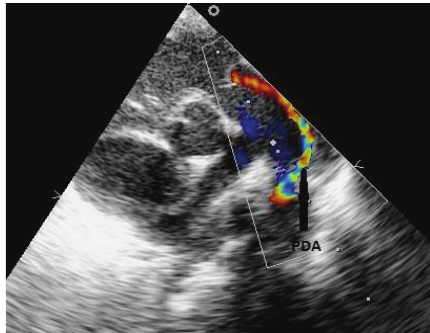
Figure 2: Transthoracic echocardiogram, parasternal short axis view showing patent ductus arteriosus.